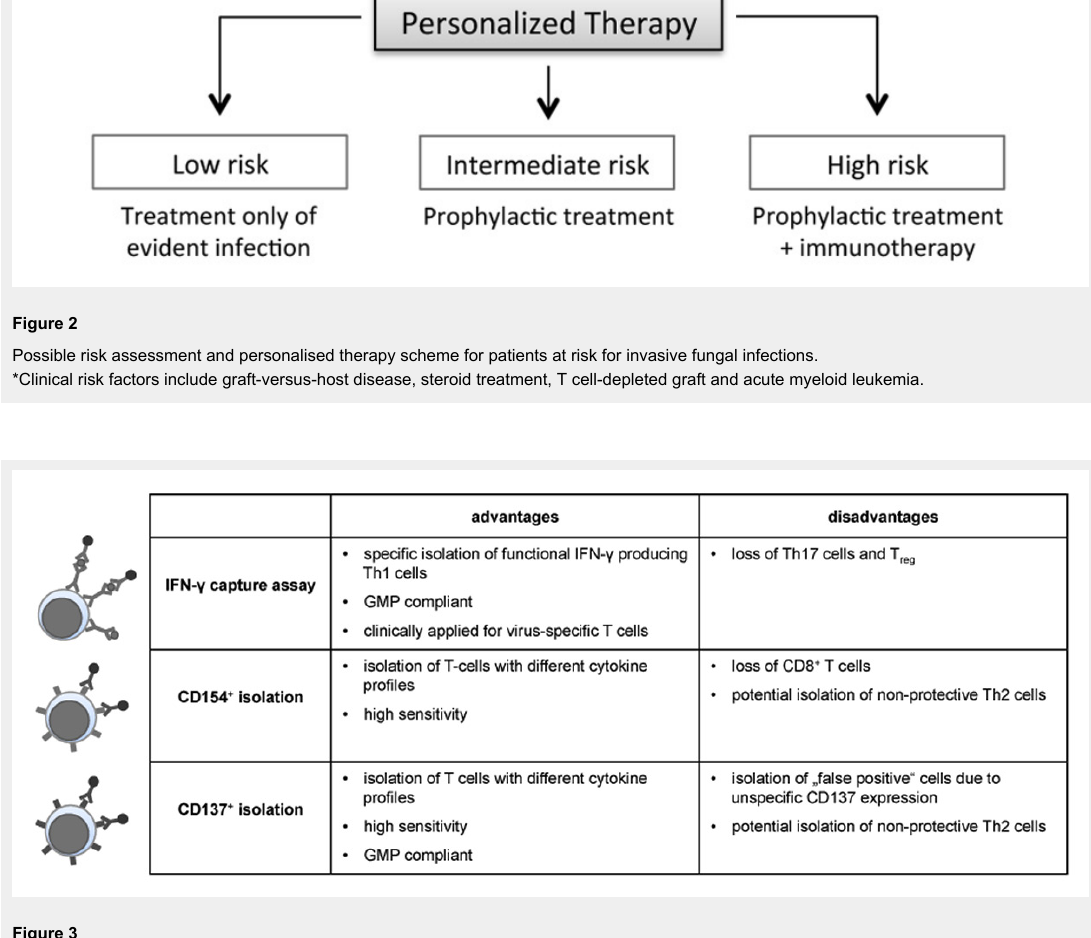
Figure 3 Advantages and disadvantages of different enrichment strategies for antigen-specific T cells. GMP = Good Manufacturing Practice; IFN =